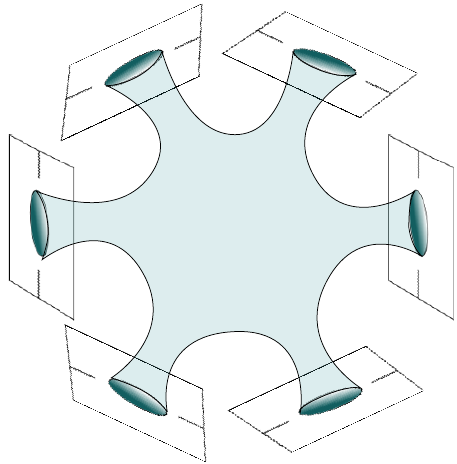
Figure 7 . Topology of a replica wormhole with n = 6. The sheets are also glued together cyclically along the cuts in the matter